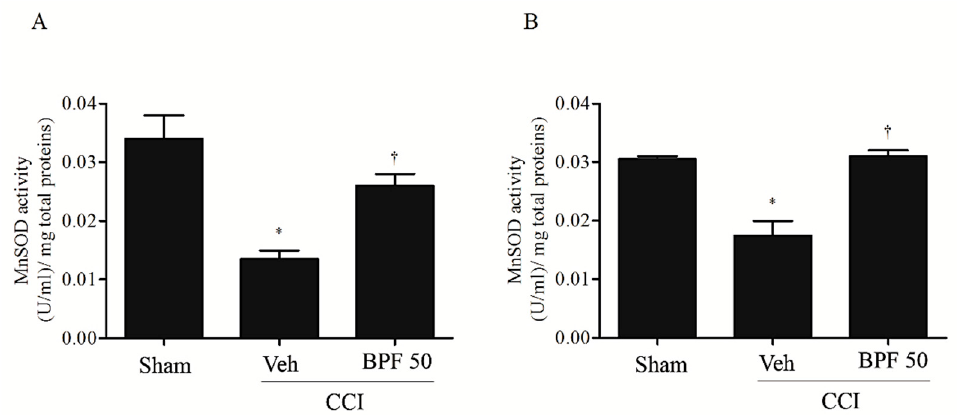
Figure 11. Acetylation on MnSOD is associated to inactivation of its biological function. MnSOD acetylation is intimately linked to inactivation of MnSOD enzymatic function either 14 days ( A ) and 21 days ( B ) post injury. In fact, when compared with sham group, CCI rats showed low levels of MnSOD activity. Subcutaneous infusion of BPF (50 mg/kg), concurrently with surgery (day 0), prevented mitochondrial proteins acetylation. Results are expressed as mean ± SEM for 6 rats. * p < 0.05 versus sham; † p < 0.05 versus vehicle + CCI.